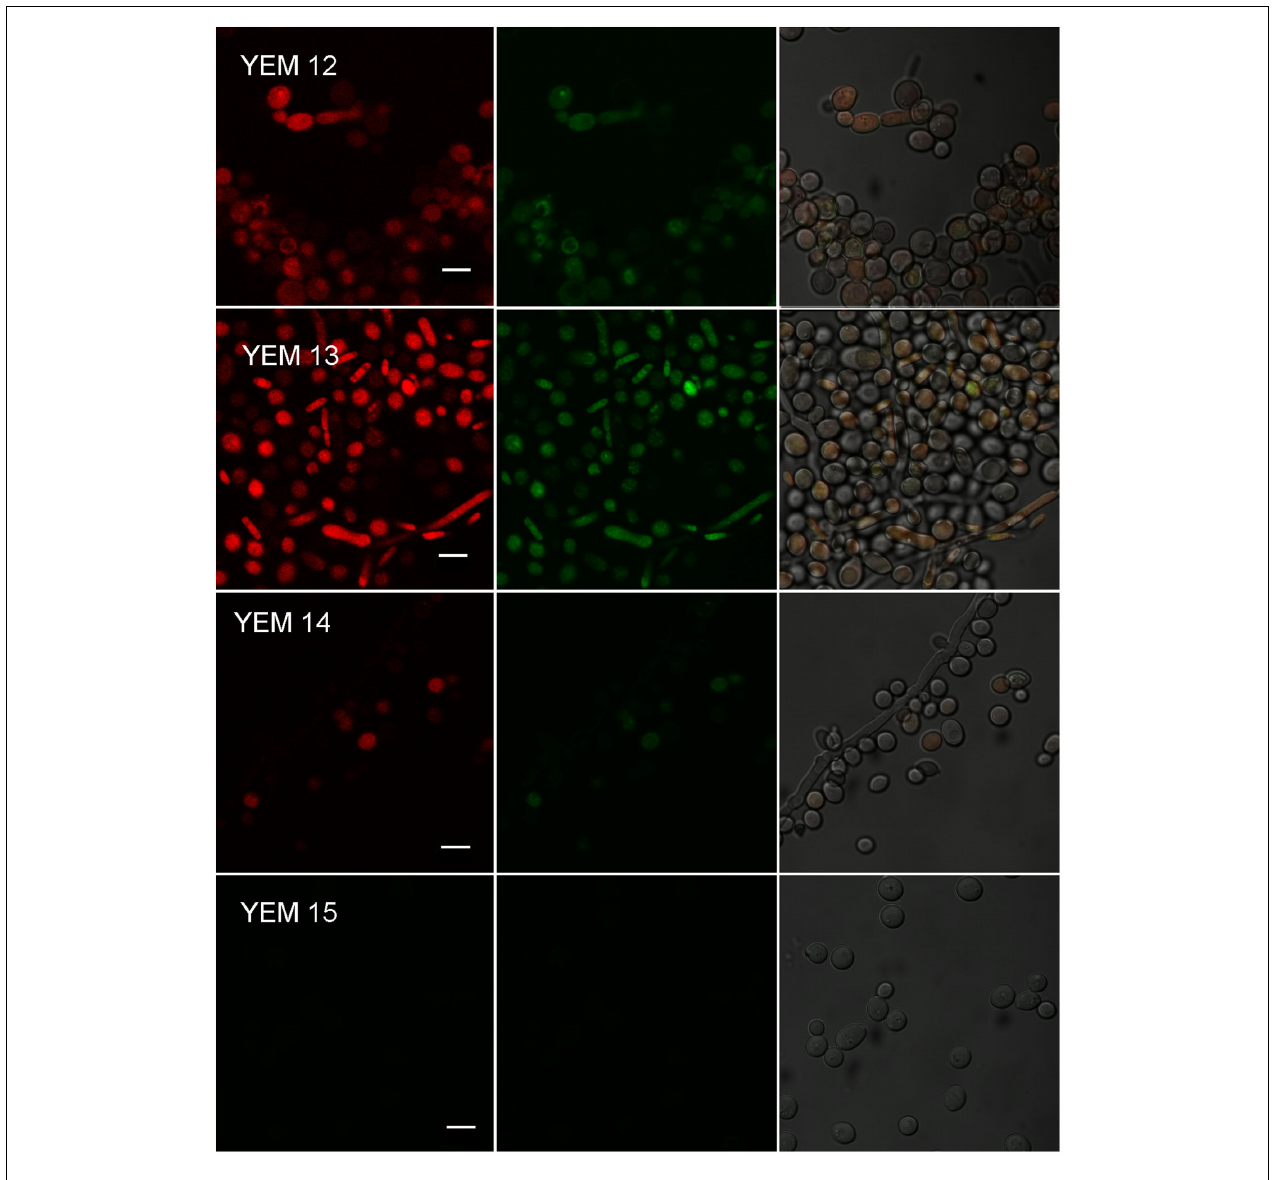
FIGURE 5 | Effect of efflux pumps on photodynamic inactivation of C. albicans . Confocal microscopy image ofYEM strains. Cells were incubated with 10 μ M R123 and 100 μ M MB and excited at